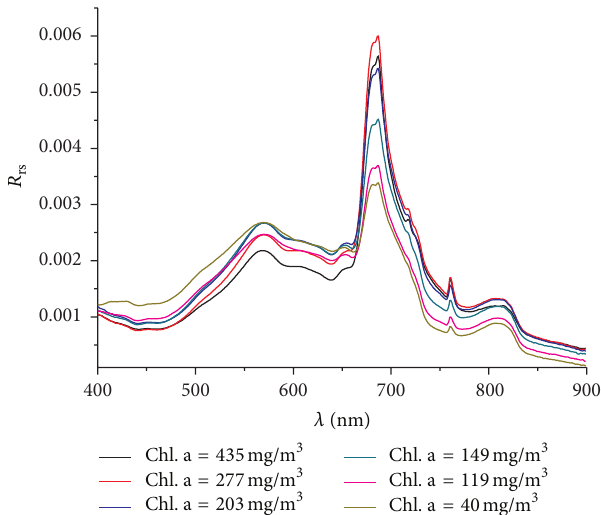
Figure 1: The remote sensing reflectance spectrum of Aureococcus anophagefferens